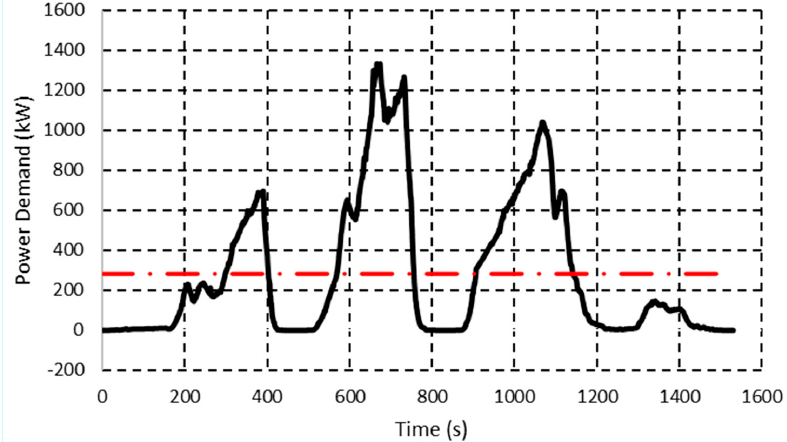
World Electric Vehicle Journal 2019 , 10 , x FOR PEER REVIEW Figure 5. Evaluated duty cycle of the current trains working in UPE route. Figure 5. Evaluated duty cycle of the current trains working in UPE route.